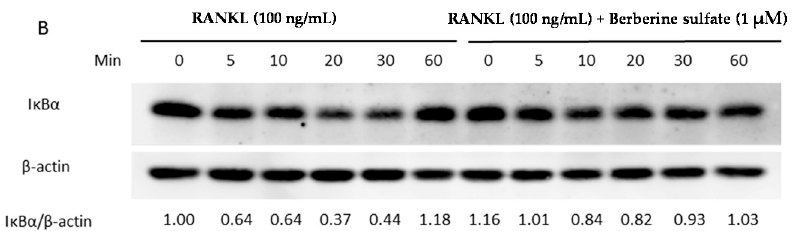
Figure 4. Berberine sulfate attenuated RANKL-stimulated NF- κ B activity. ( A ) RAW264.7 cells stably transfected with an NF- κ B transcriptional luciferase reporter construct, were pretreated with indicated concentration of berberine sulfate for 1 h and subsequently stimulated with RANKL (50 ng/mL) for an additional 6 h. The cells were harvested, and the luciferase activity was assayed. ( n = 6). “ − “ means RANKL untreated; “+” means RANKL treated. * p < 0.05, ** p < 0.01 versus untreated control; ( B ) BMM cells were pretreated with serum-free culture medium for 3 h, and berberine sulfate (1 μ M) for 1 h and then were incubated with RANKL (100 ng/mL) for indicated times. The levels of I κ B- α were evaluated by Western blot analysis